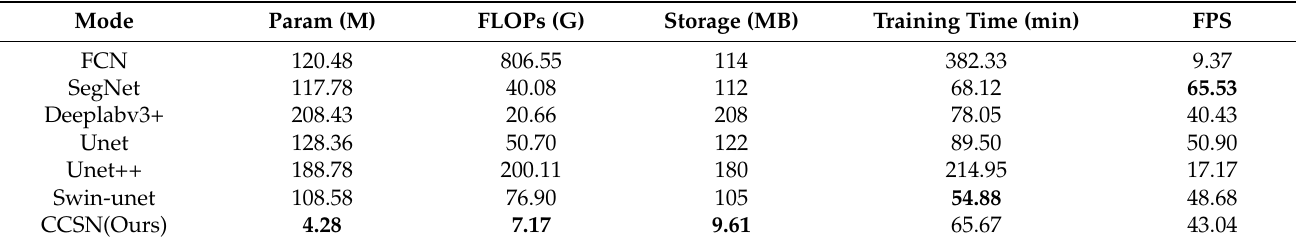
Table 10. Computational comparison of CCSN and other